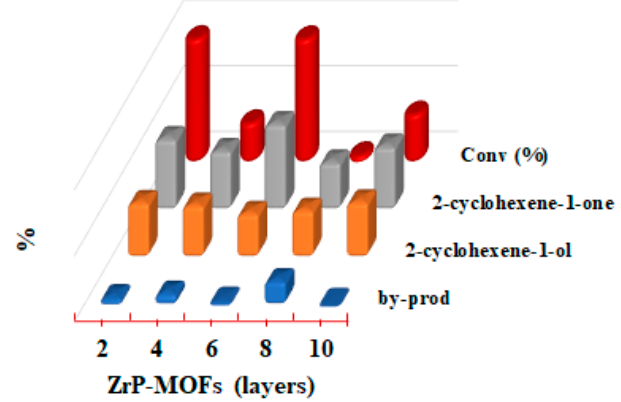
Figure 6. Conversion (%) and product distribution (%) with different layers of